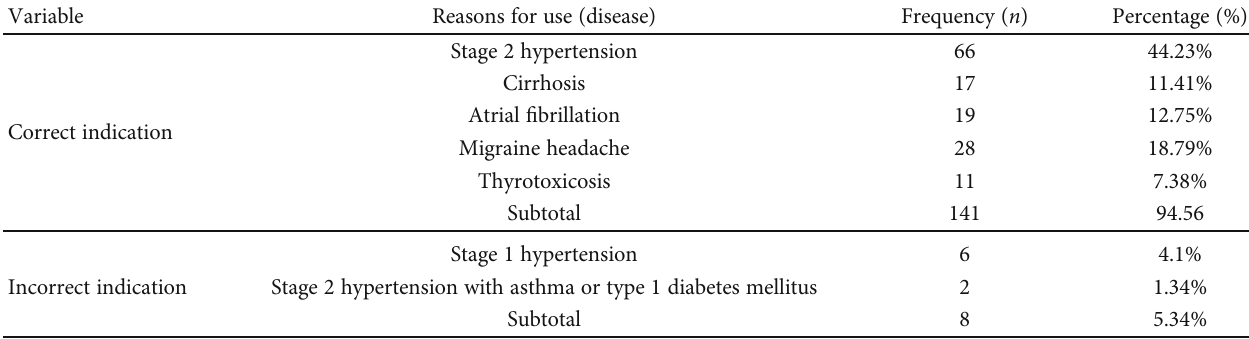
Table 3: Reasons and indications of beta-blockers used in the medical wards of NGH within 2 years. Variable